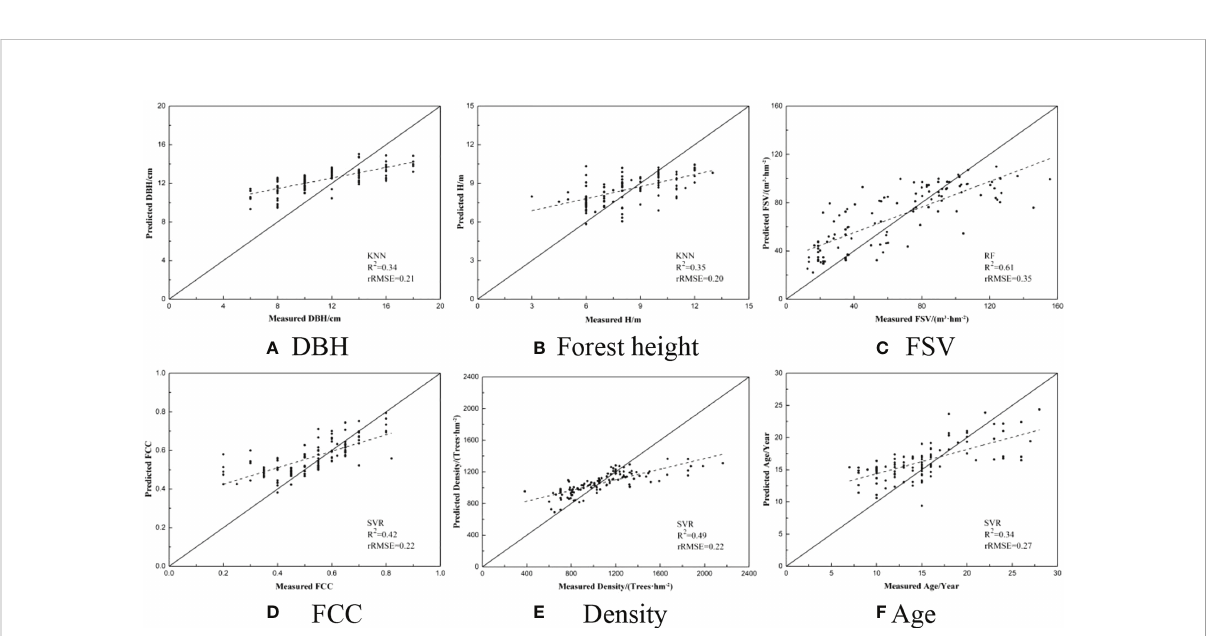
FIGURE 9 Scatterplots between the ground measured and predicted forest parameters. (A) DBH (B) Forest height (C) FSV (D) FCC (E) Density (F)